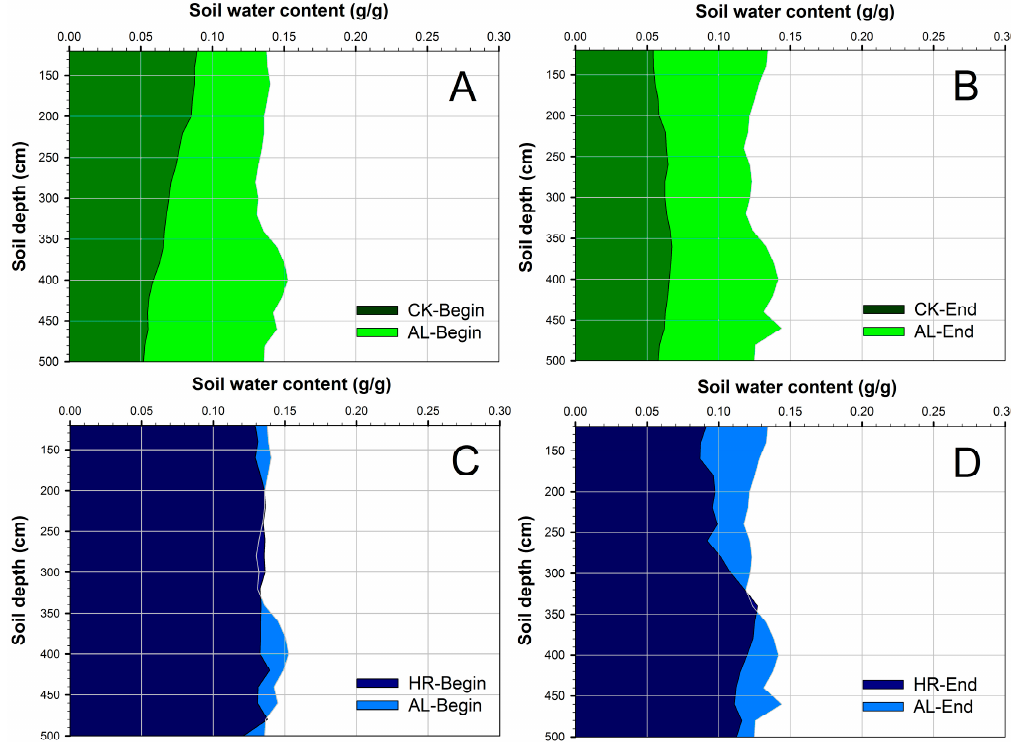
Figure 2. SWS changes within deep profiles during the growing season. ( A ) The SWC under CK (CK-Begin) and abandoned land (AL-Begin) at the beginning of the growing season; ( B ) The SWC under CK (CK-End) and abandoned land (AL-End) at the end of the growing season; ( C ) The SWC under HR (HR-Begin) and abandoned land (AL-Begin) at the beginning of the growing season; ( D ) The SWC under HR (HR-End) and abandoned land (AL-End) at the end of the growing season.